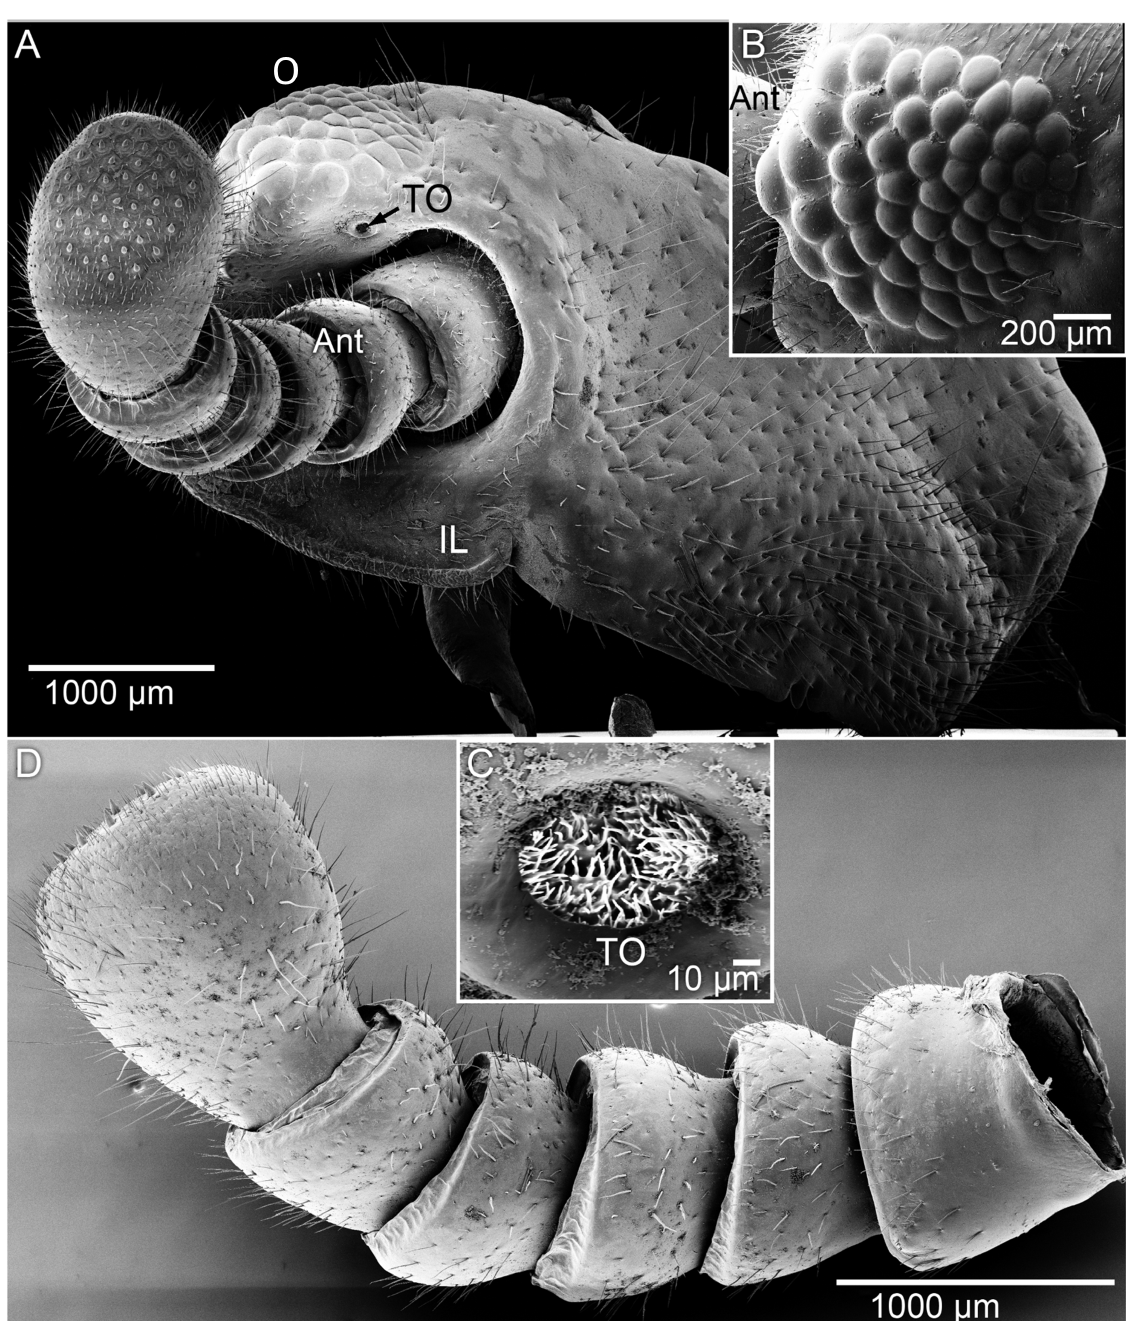
Fig. 7. Zephronia viridisoma Rosenmejer & Wesener sp. nov., paratype, ♂ (ZFMK MYR8786), head, scanning elelctron micrographs. A . Lateral view. B . Right eye. C . Organ of Tömösváry. D . Left antenna, lateral view. Abbreviations: Ant = antenna; IL = incisura lateralis; O = ommatidia; TO = organ of